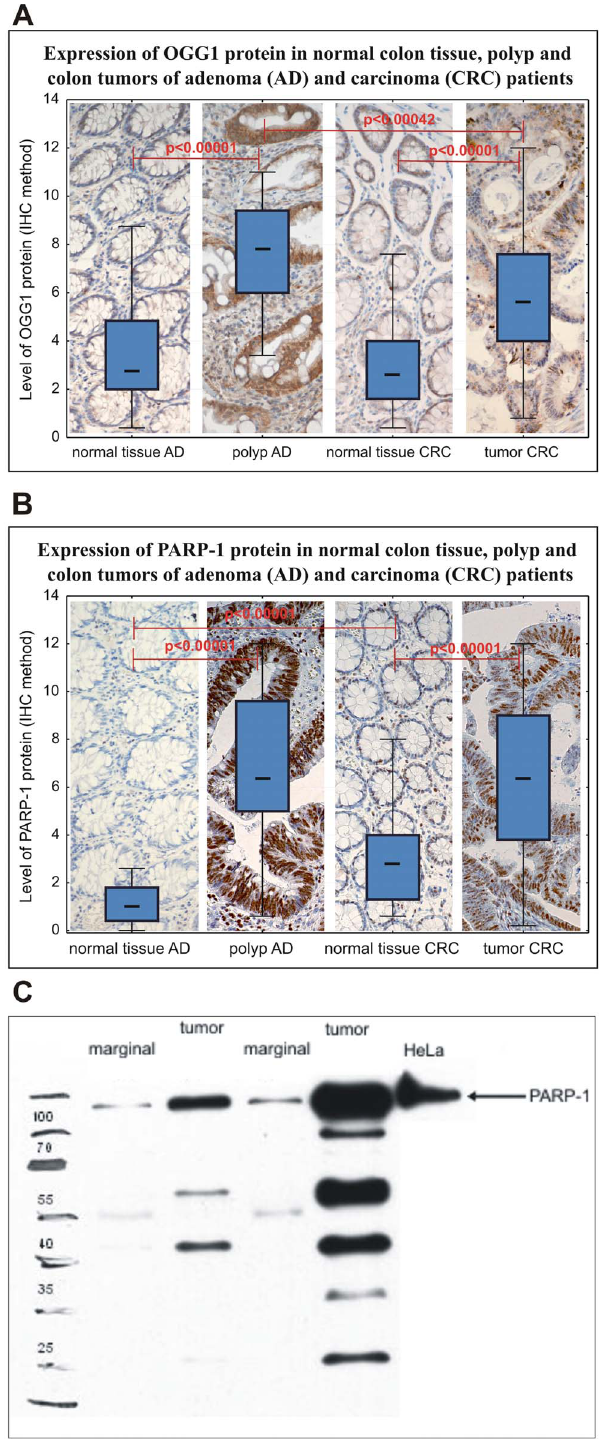
Fig. 3. Comparison of the expression of OGG1 (A) and PARP-1 (B) protein in normal colon tissue, polyp and cancer tissue of adenoma (AD, n 5 68) and carcinoma (CRC, n 5 103) patients. Immunohistochemical detection in paraffin embedded sections stained with hematoxylin and eosin.